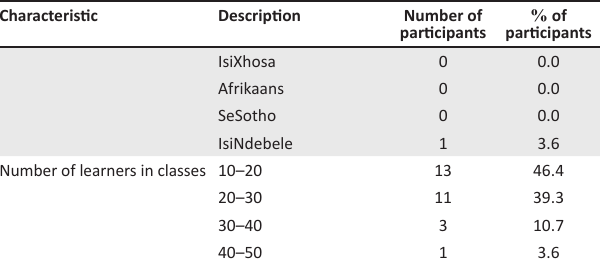
TABLE 1 (Continous): Professional profile and teaching context ( n = 28).